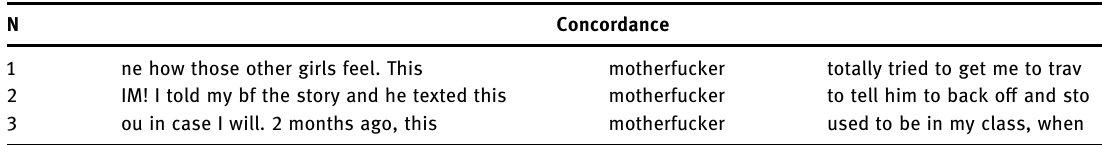
Table 15: Concordance lines for motherfucker